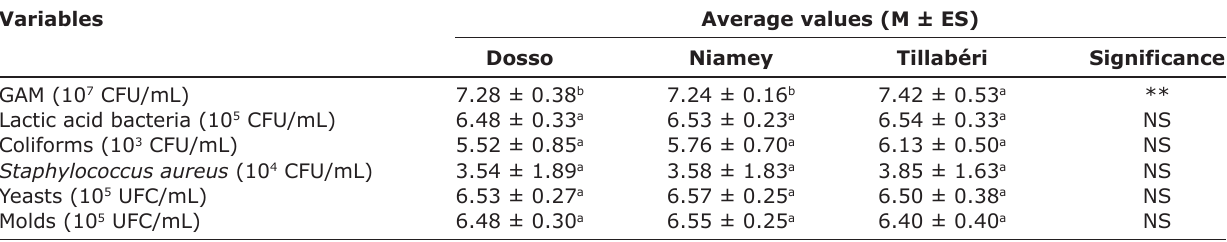
Table-4: Average values of the microorganisms counted in the milk according to the regions. Variables